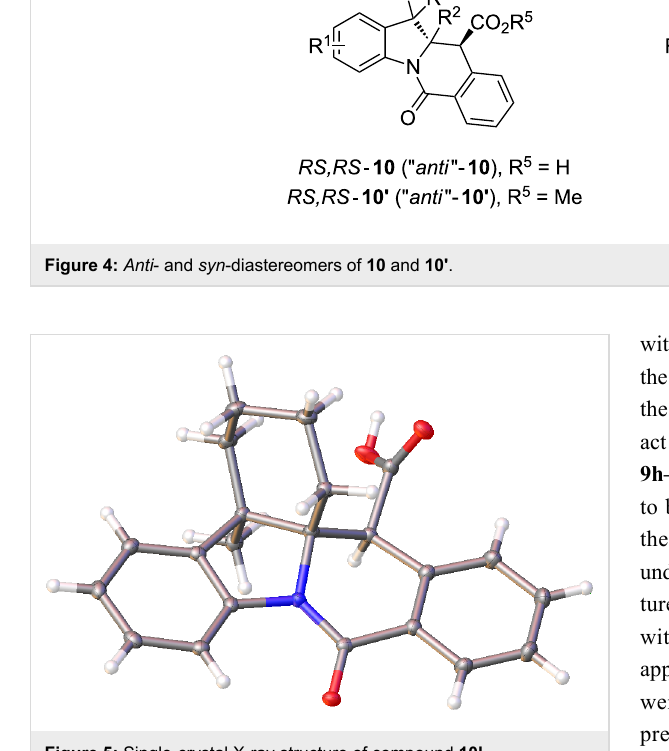
Figure 5: Single-crystal X-ray structure of compound 10l